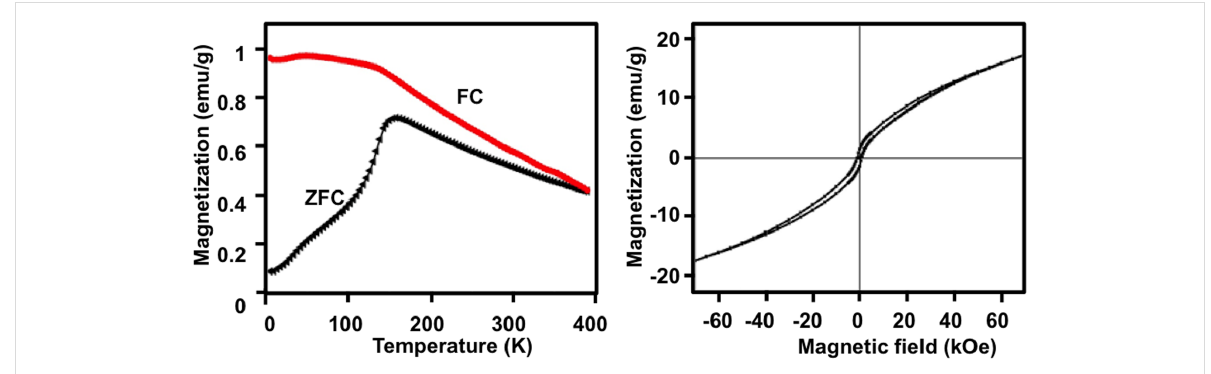
Figure 8: Magnetic properties of the Au@Co nanochains: (a) zero-field-cooling (ZFC), field-cooled (FC) at 100 Oe applied field, and (b) field-depend- ent magnetization ( M vs H ) hysteresis loop.